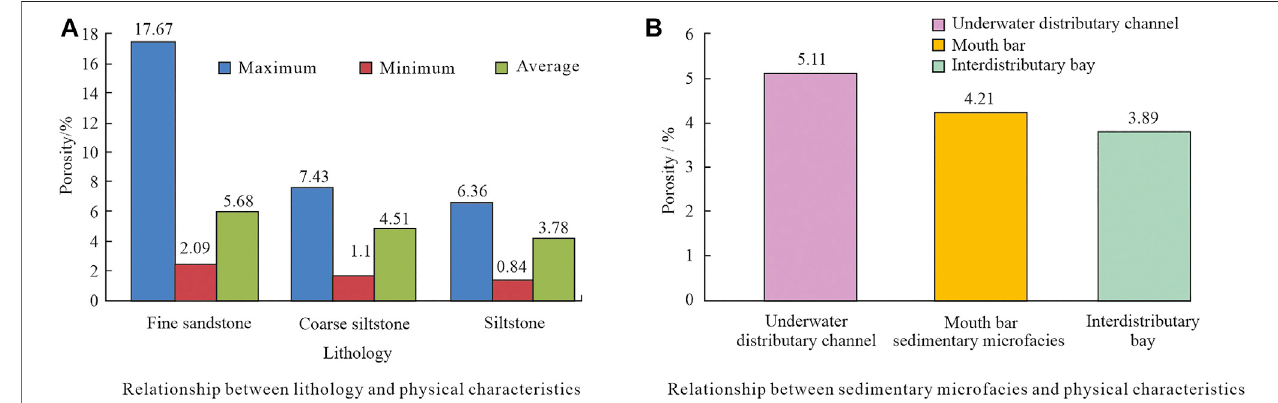
FIGURE 13 | Relationship of physical characteristics respectively with lithology and sedimentary microfacies of the Xiaoheba Formation in the northern area; (A) Relationship between lithology and physical characteristics; (B) Relationship between sedimentary microfacies and physical characteristics